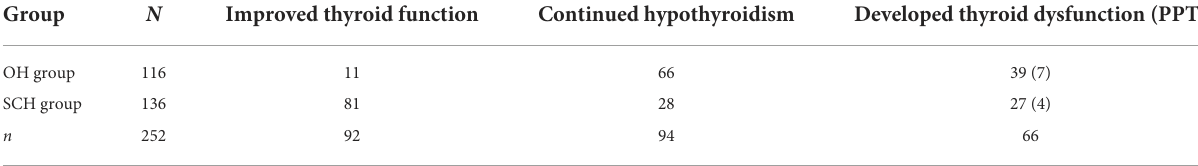
TABLE 2 Thyroid function of the 12th month postpartum in OH and SCH groups. Group N Improved thyroid function Continued hypothyroidism Developed thyroid dysfunction (PPT)